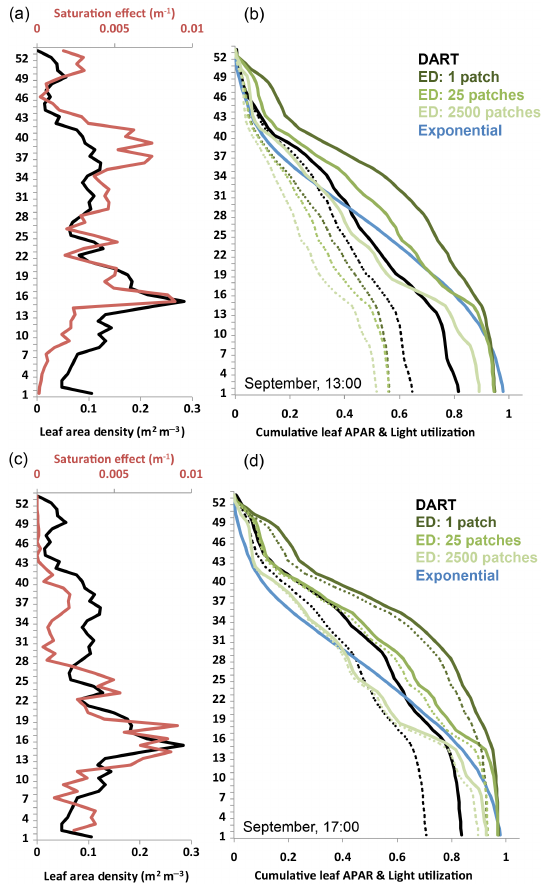
Figure 6. Forest 3-D structure alters total leaf absorption, light utilization, and the vertical distribution of light saturation effects compared to more simplified representations of the Amazon for- est scene. (a) Vertical profiles of leaf area density (black) and light saturation effect (red, difference between absorbed and utilized light) for September 13:00 DART simulations. (b) DART cumula- tive l APAR (black) and light utilization (dashed black); differences between light absorption and light utilization in DART simulations are plotted as the red curve in panel (a) to illustrate the vertical dis- tribution of light saturation effects through the profile of canopy leaf area. DART results were compared to an exponential model of light extinction (blue, following Stark et al., 2012) and ED2 model simu- lations (green). Solid and dashed green lines depict cumulative leaf absorption and cumulative light utilization, respectively, for ED2 simulations with 1, 25, and 2500 patches. (c, d) Same as (a) and (b) for September 17:00 illumination